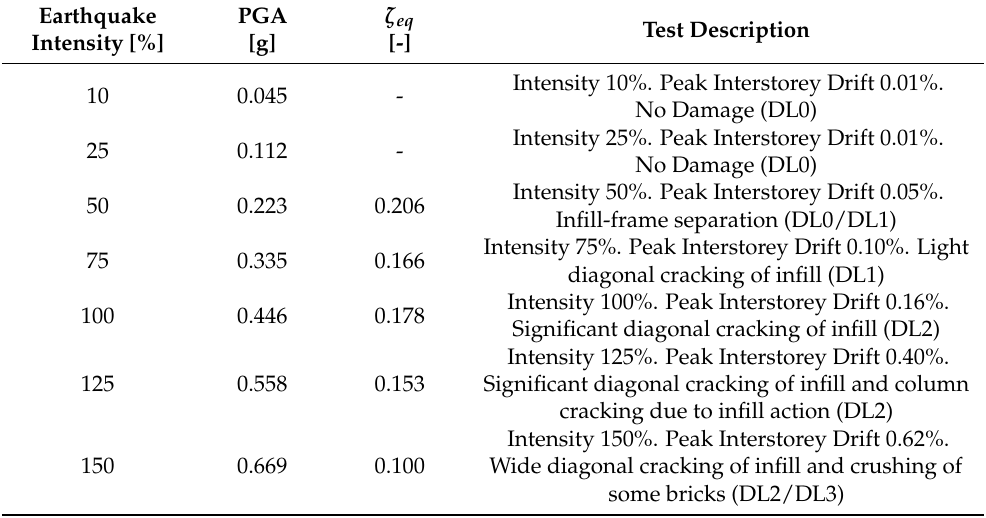
Table 4. Pseudo-dynamic test results and damage description for F2_4S_M